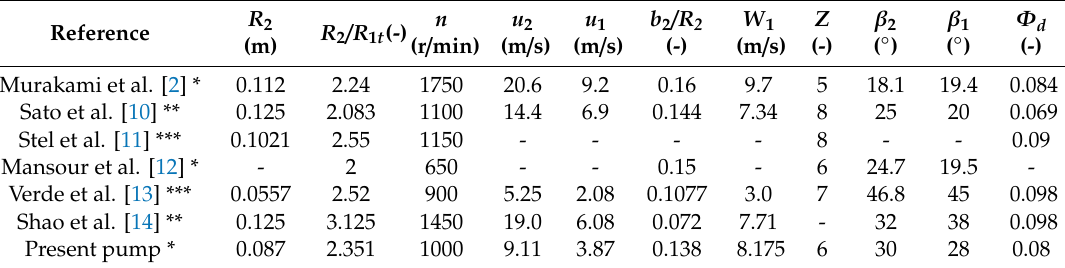
Table 1. List of pump parameters in reports on flow